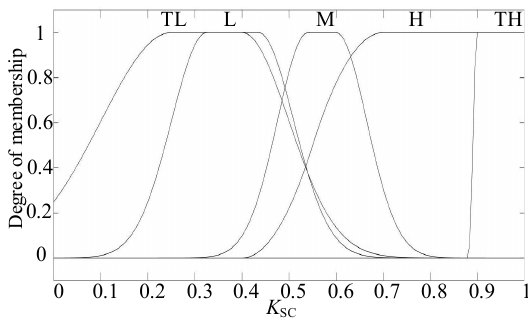
Figure 9. Membership function of K SC .